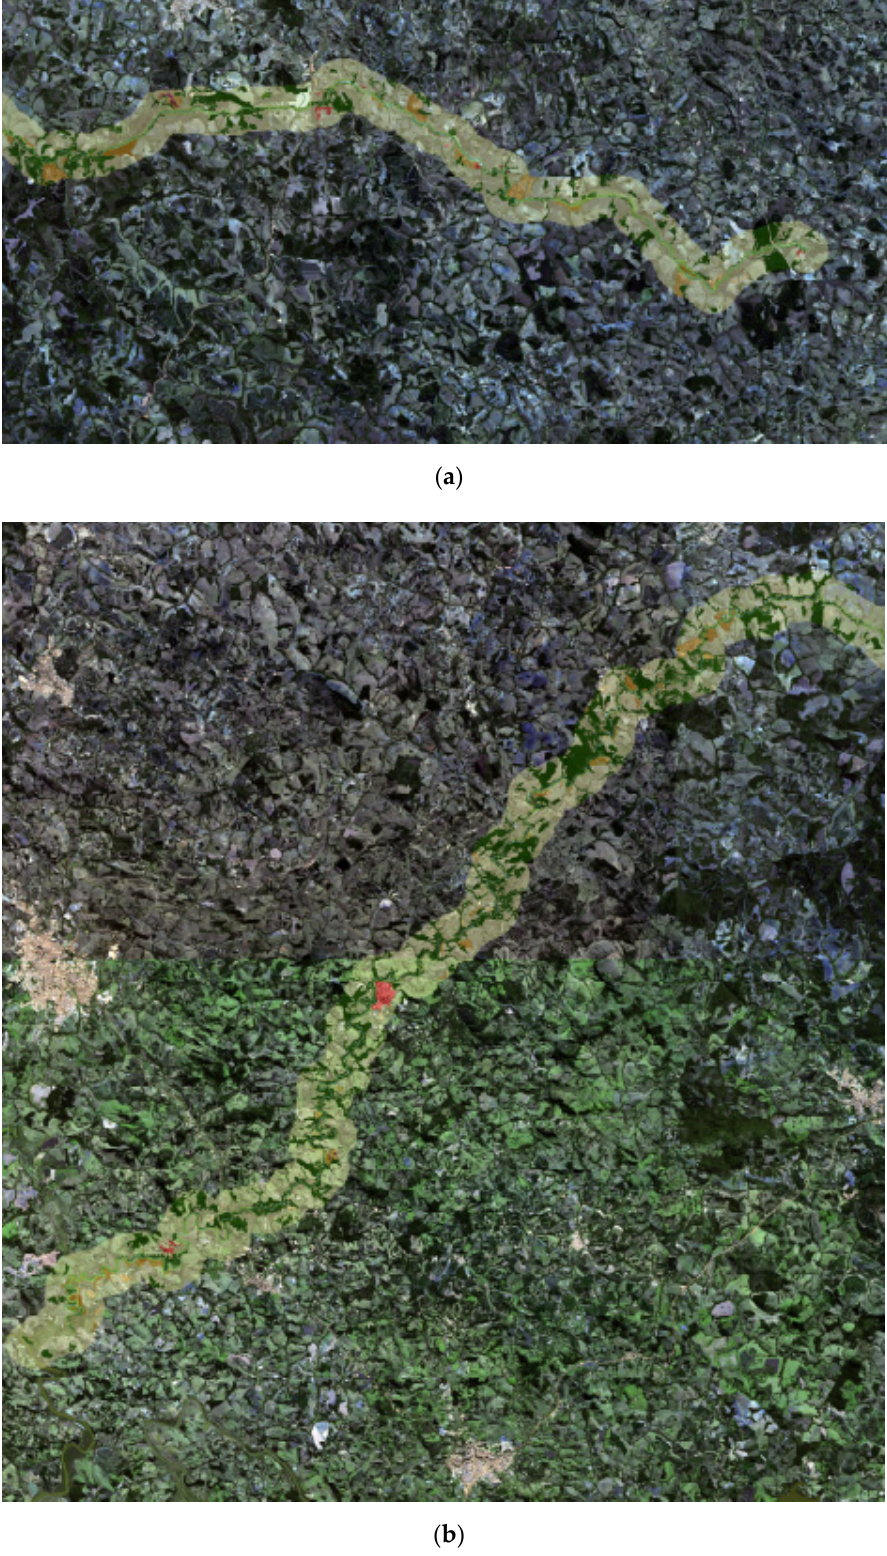
Figure 3. ( a ) Study area image—upper river course, ( b ) study area image—lower river course.